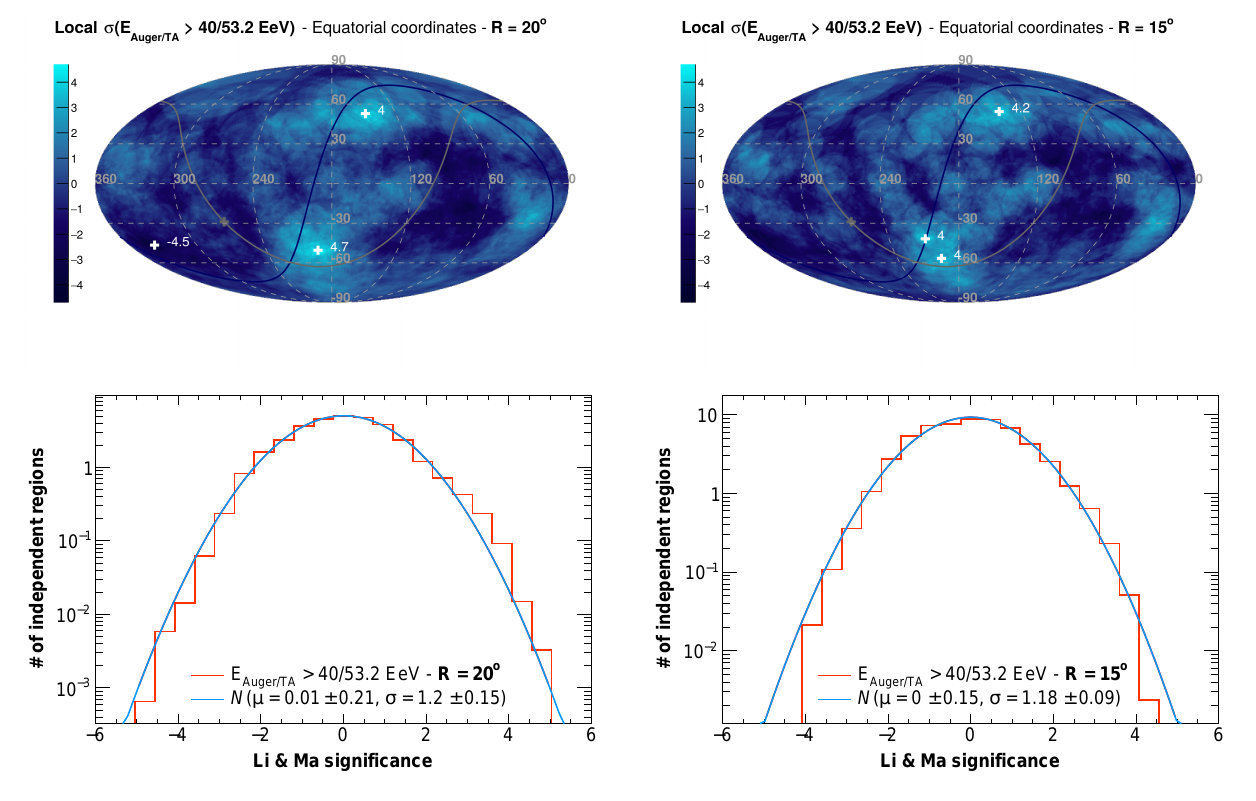
Figure 5. Top: Significance map reconstructed at E Auger / TA > 40 / 53 . 2EeV with a 20 ◦ search radius. White crosses indicate deviations from isotropy with > 4 σ local significance. Bottom: Distribution of the Li & Ma significance over the sphere.